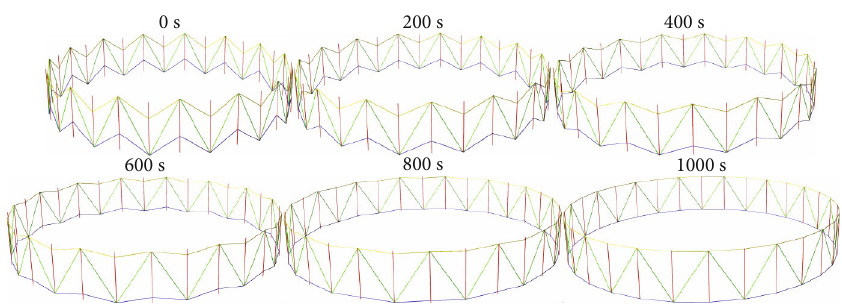
Figure 14: Deployment con fi gurations in the second